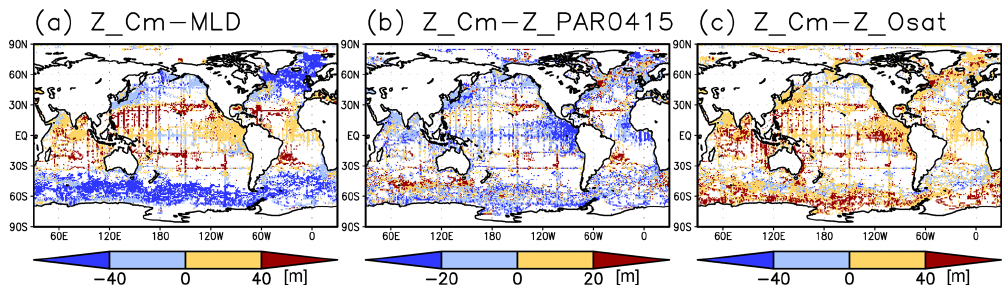
Figure 4. Depth differences between the chlorophyll a (Chl a ) maximum and (a) the mixed layer, (b) the photosynthetically active layer ( > 0 . 415molm − 2 d − 1 of photosynthetically available radiation), and (c) the oxygen-oversaturated